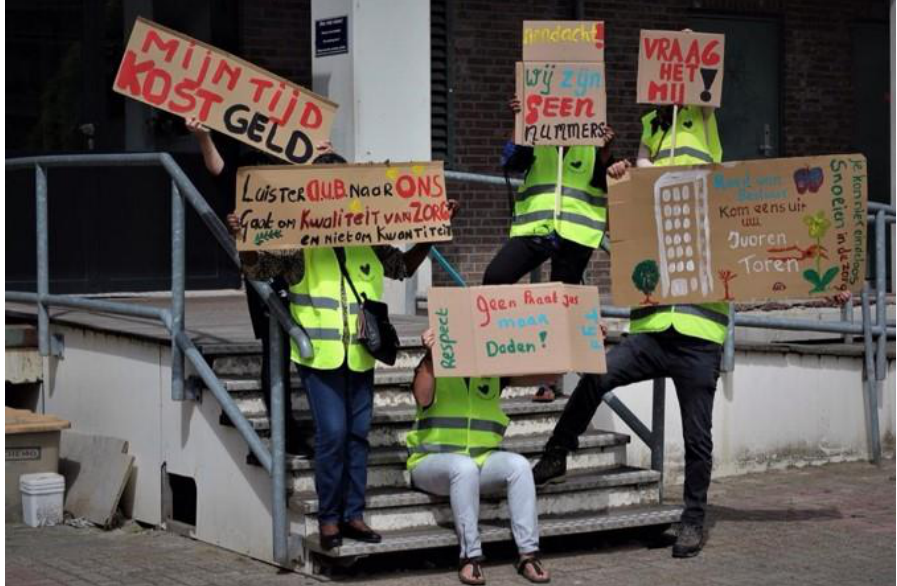
Figure 4. Picture of community researchers with protest signs and yellow vests.